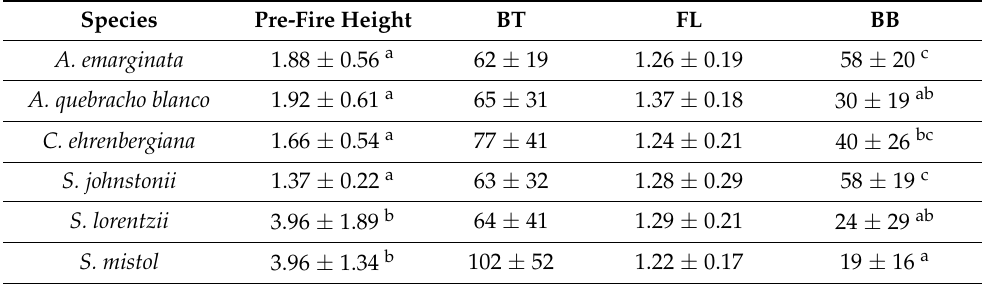
Table 2. Mean and standard deviation for the pre-fire height (m), burning time (BT, s), flame length (FL, m), and burnt biomass (BB, %). Different letters indicate significant differences, according to LSD Fisher pairwise comparison procedure with α :